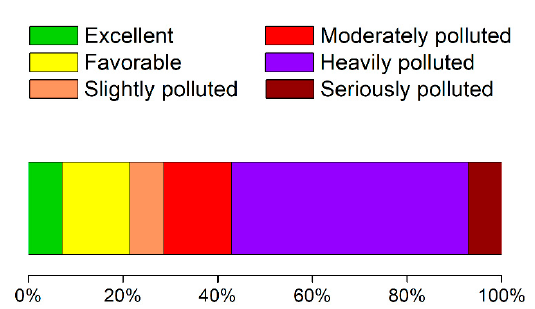
Figure 2. Proportion of days with different pollution levels.